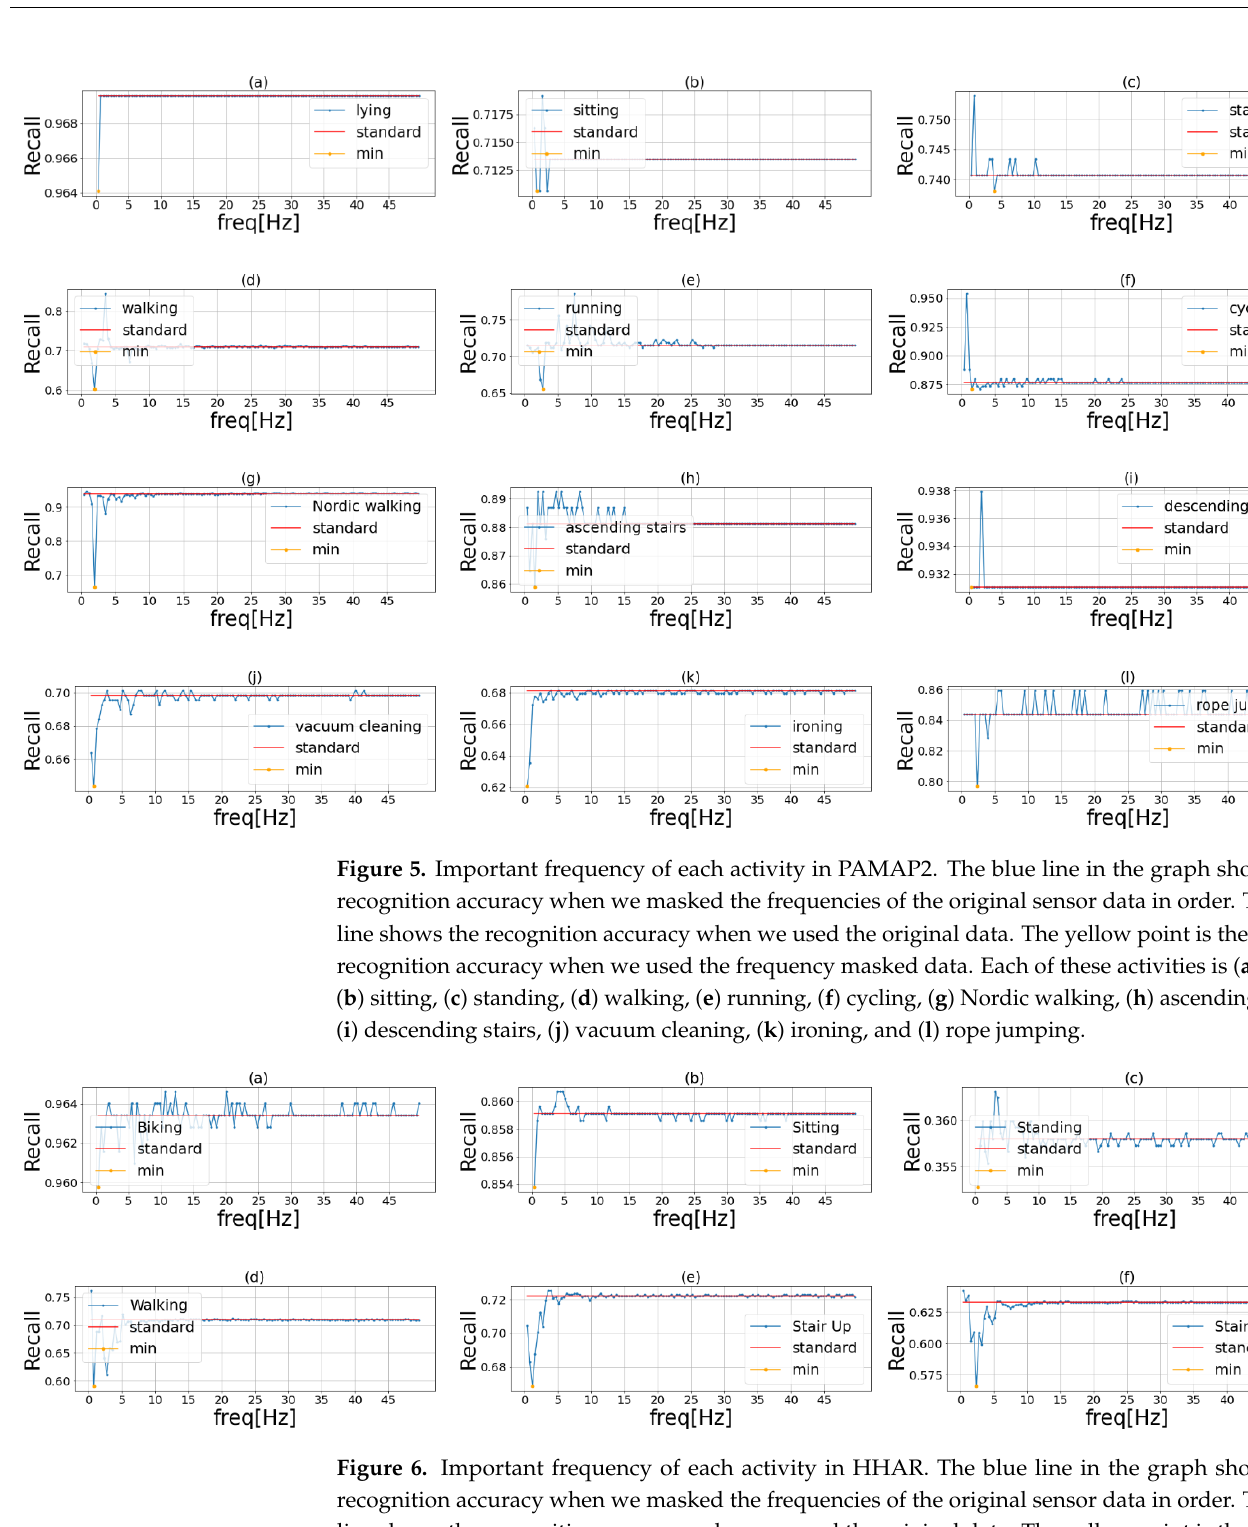
Table 5. Important frequency of each activity in UniMiB.